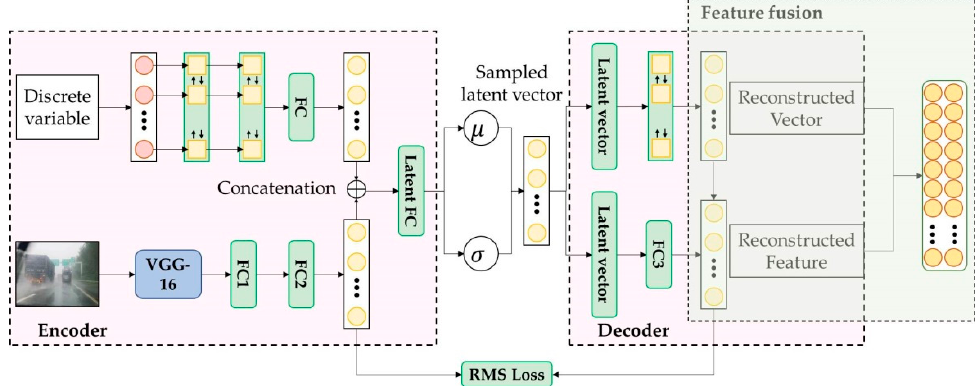
Figure 3. Autoencoder for multimodal feature extraction.